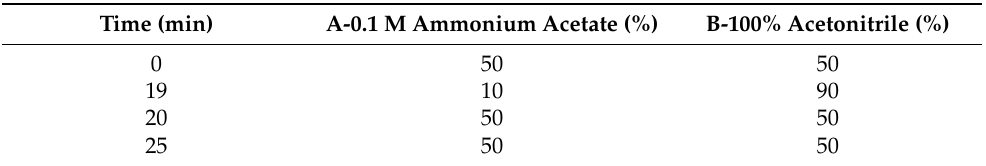
Table 5. Gradient elution program (Flow rate 1